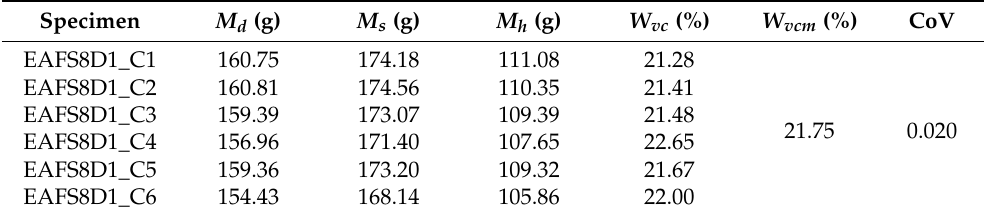
Table 12. Results of water absorption test by immersion under vacuum for the for the EAFS8D1 mixture.